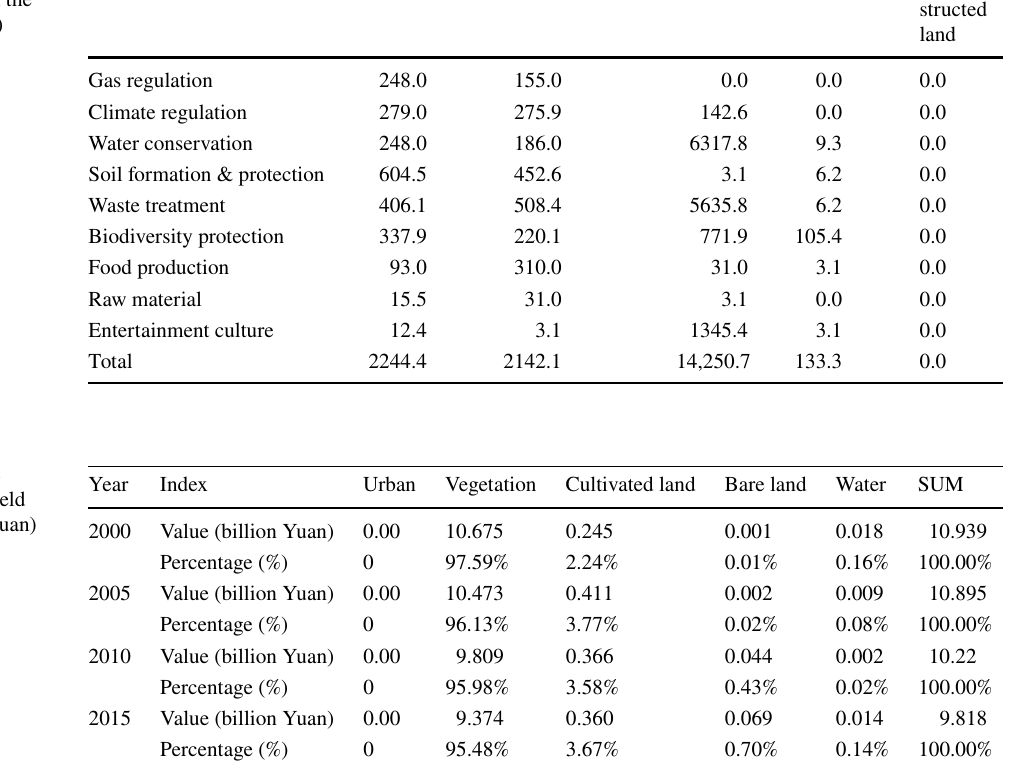
Table 5 Ecosystem types and LUCC value coefficients in the Shengli coalfield (Yuan/ha)